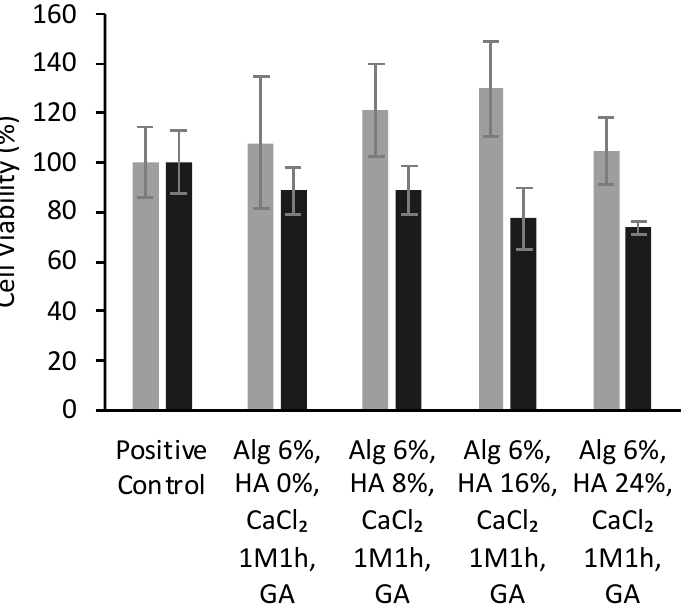
Figure 8. Viability (expressed in %) of BALB cells after 24 (grey bars) and 48 h (black) of contact with alginate-HA-GA aerogel scaffolds determined by WST-1 tests. There were no statistically significant differences among groups ( t- test; p < 0.05).